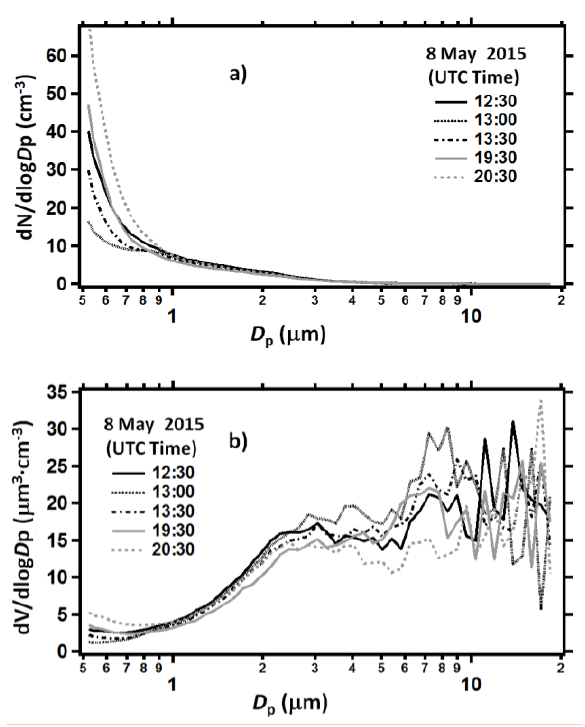
Figure 11. ( a ) Number ( N ) and ( b ) volume ( V ) particle concentrations versus the particle diameter ( D p ) on a logarithmic scale within the 0.52–20 μm range at different day hours on 8 May 2015.